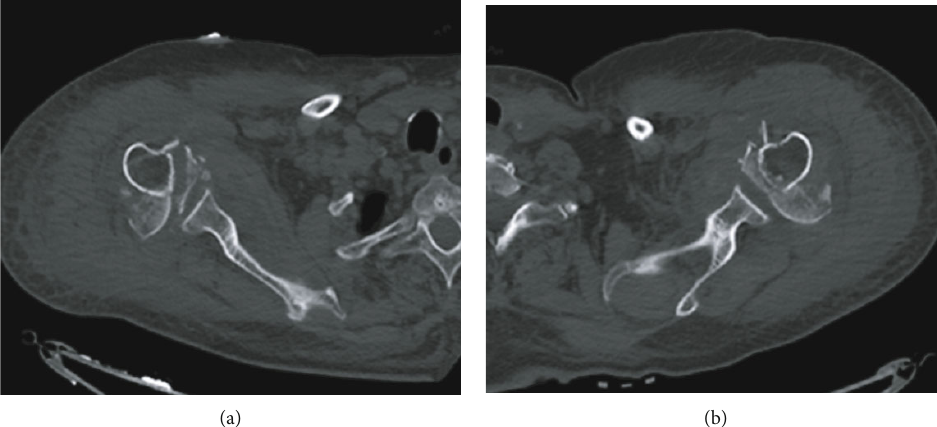
Figure 2: (a) CT of the right shoulder showing a comminuted displaced fracture of the proximal humerus. (b) CT of the left shoulder showing a comminuted displaced fracture of the proximal